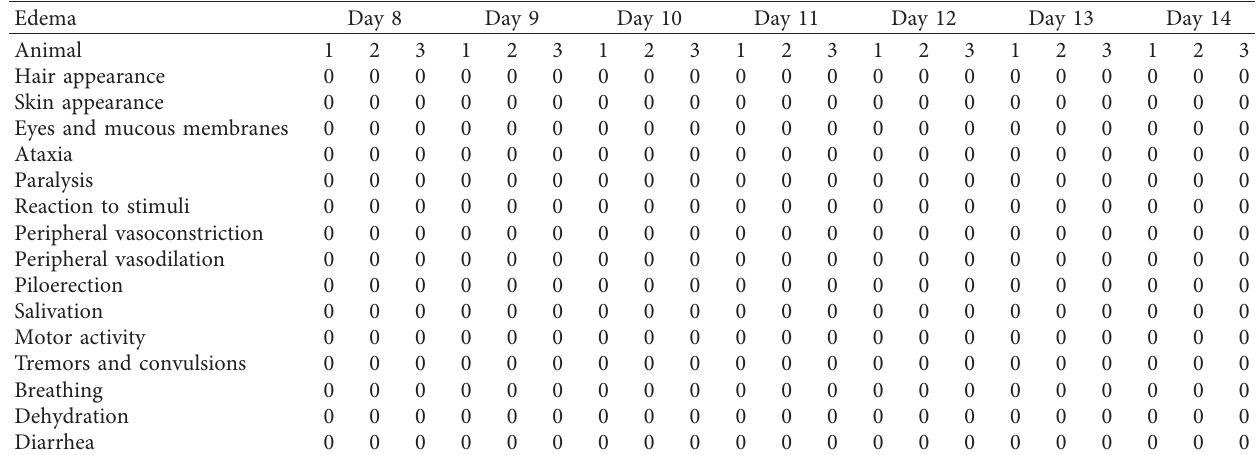
Table 8: Evaluation scale of dermal reactions of